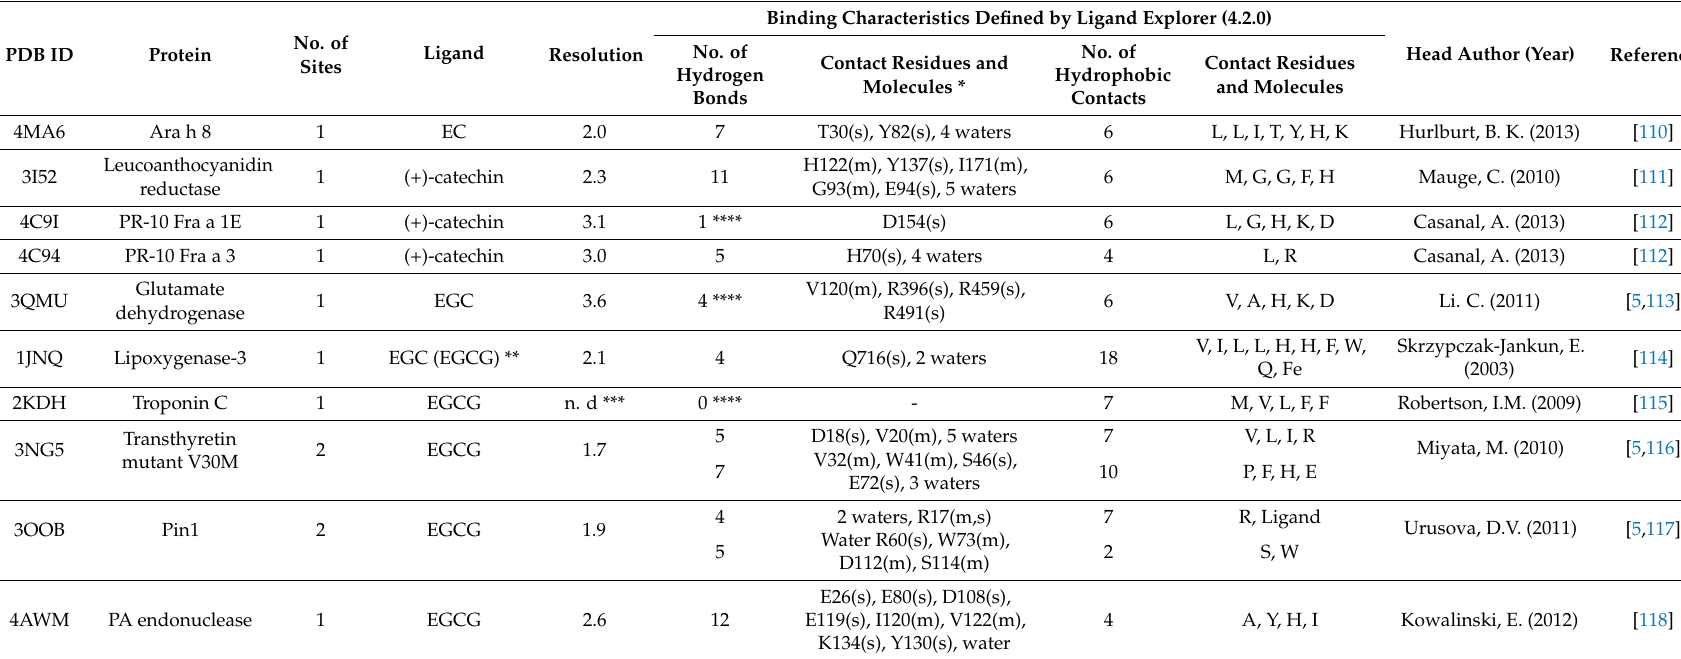
* Words in parentheses indicate main chain or side chain atoms which participate in hydrogen bonds. ** EGC that lacks galloyl moiety binds to the substrate binding site and the iron cofactor. *** There is no resolution definition (criterion) of solution NMR. **** Water atoms were not observed because of their low resolution, their vigorous motion or solution NMR